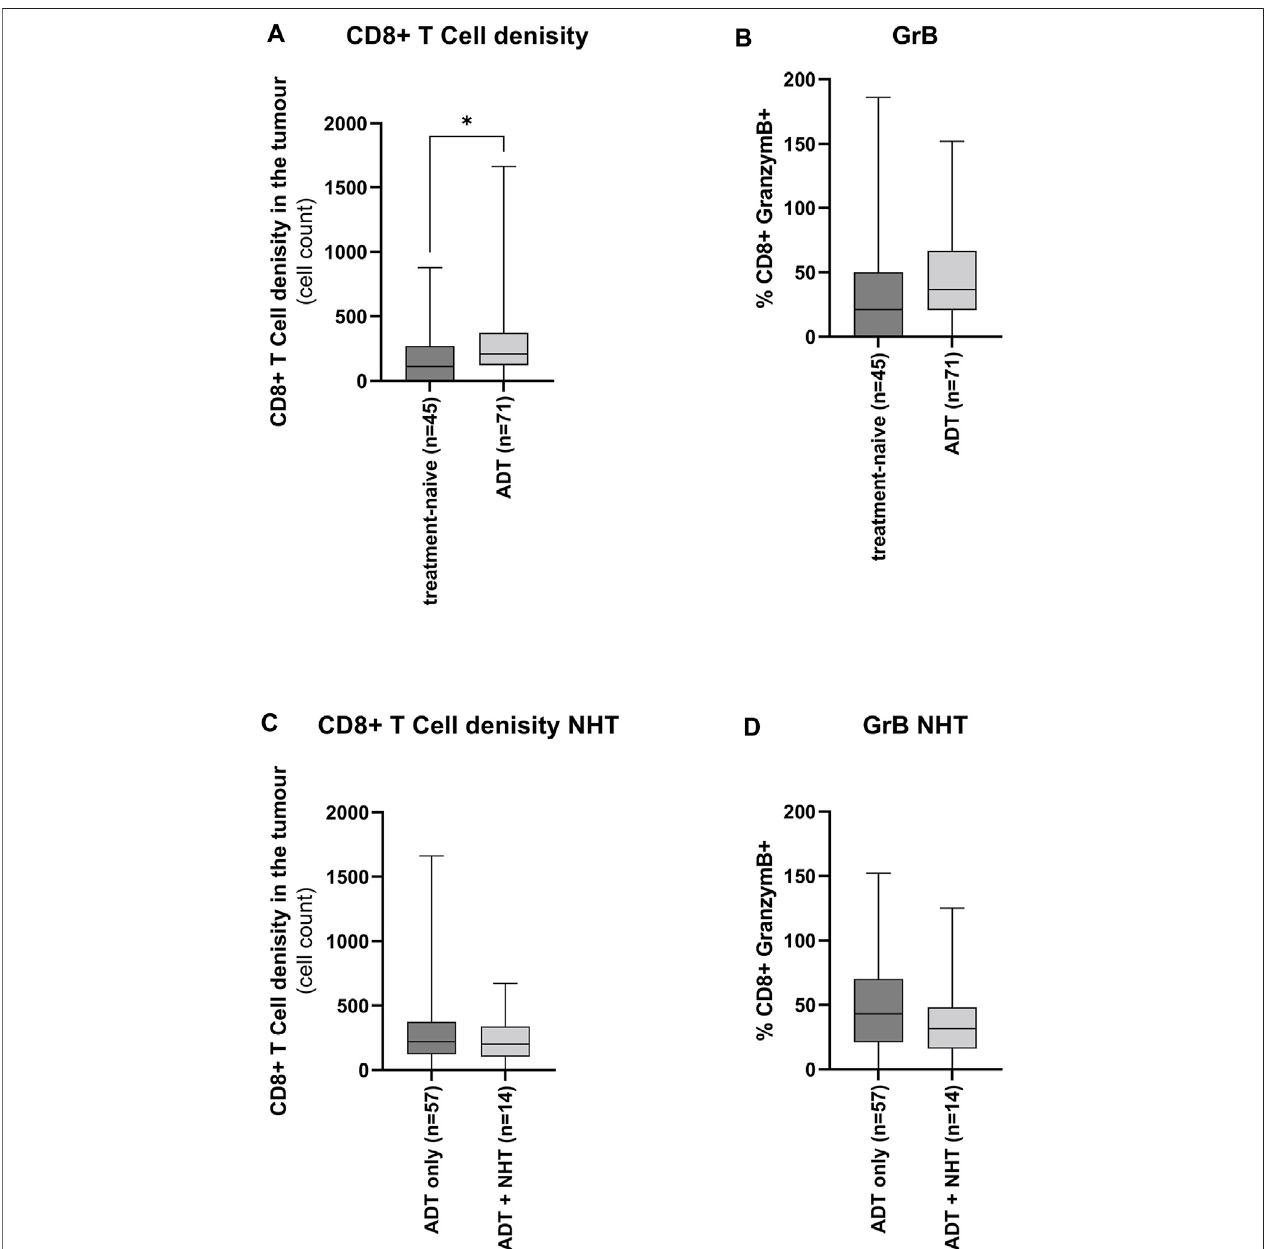
FIGURE5| In fl uenceofADTontheCD8 + T-celltumourin fi ltrates(A+B)Graphicalillustration ofthein fl uenceofADTonCD8 + T-cells (A) in fi ltrationand (B) activity. The “ treatment-naïve ” cohort included 45 samples and the “ ADT ” cohort 71 samples. (C + D) Graphical illustration of the in fl uence of ADT of additional treatment with NHT on CD8 + T-cells (C) in fi ltration and (D) activity. The “ ADT only ” cohort included 57 samples and the “ ADT + NHT ” cohort 14 samples. Values are expressed as Box Whisker Plot (min to max). All differences highlighted by asterisks were statistically signi fi cant (*: p ≤ 0.05).